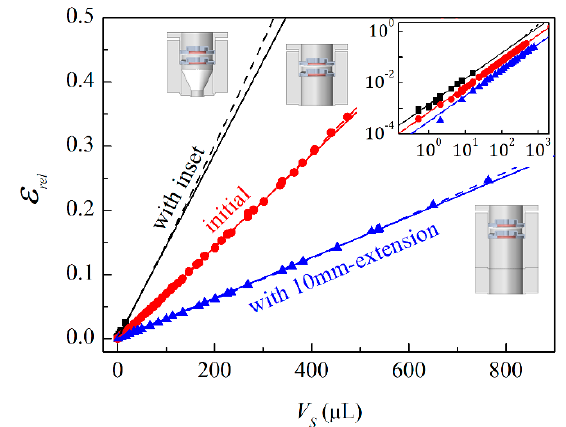
Figure 2. Measurements of stainless steel balls with different diameters and combinations thereof. Symbols reflect measured signal, ε rel , versus the geometrically calculated ball volumes, V S . Data for the initial sensor ( V 0 ~1300 µ L) are highlighted by red circles. Black rectangles and blue up triangles represent data for sensors with a conical inset (–700 µ L) and with a 10 mm-extension ( + 1330 µ L), respectively. Solid and dashed lines show the fit results using (9) and (11), respectively. f = 232 Hz. Inset: The same data shown in log-log scale. Table 1. Comparison of geometrically estimated initial volumes of the sensor and measured volumes calculated by Equations (9) and (11).